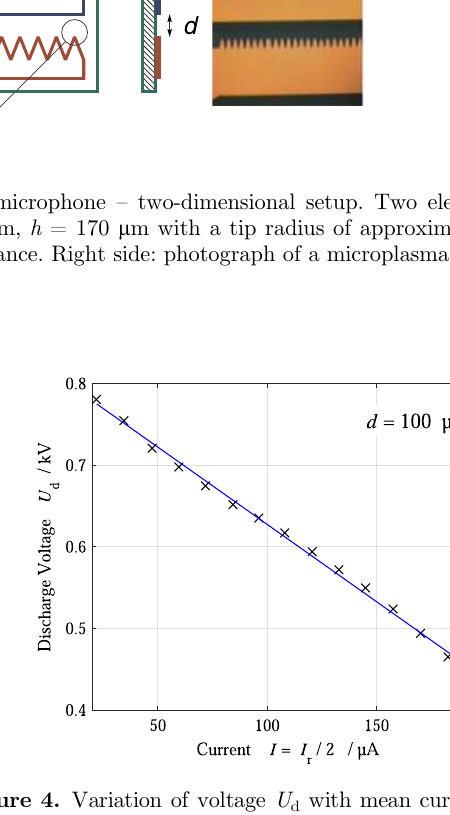
Figure 3. Variation of voltage U d with mean current I associated with a point-to-plane discharge (Fig. 1) – [16].